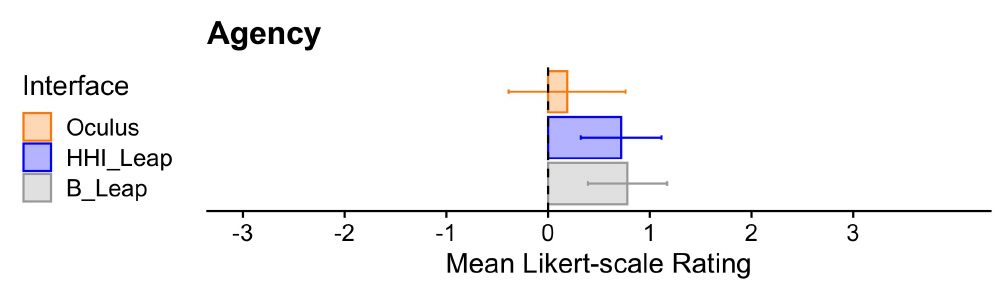
Figure 11. Mean scores for Agency, converted to a scale of − 3 to 3, with 95%